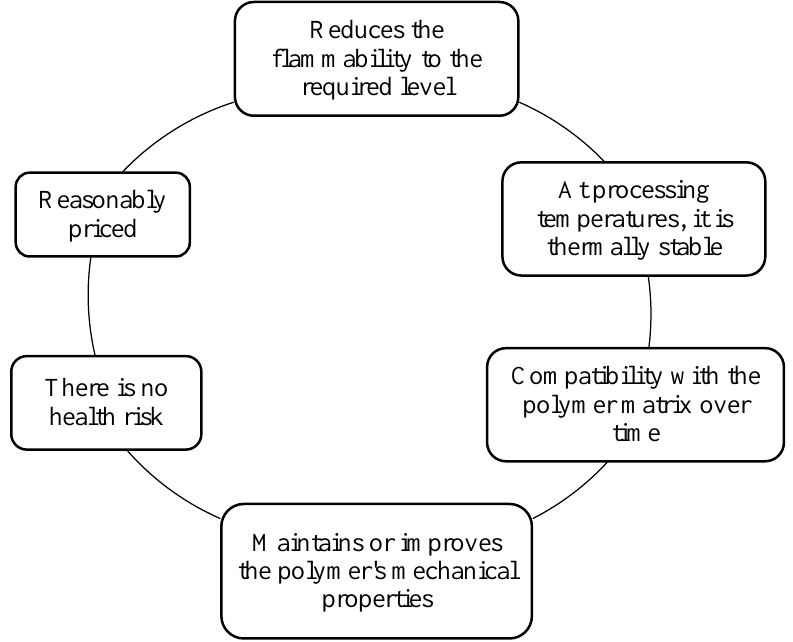
Figure 4. The properties of an ideal flame retardant system.